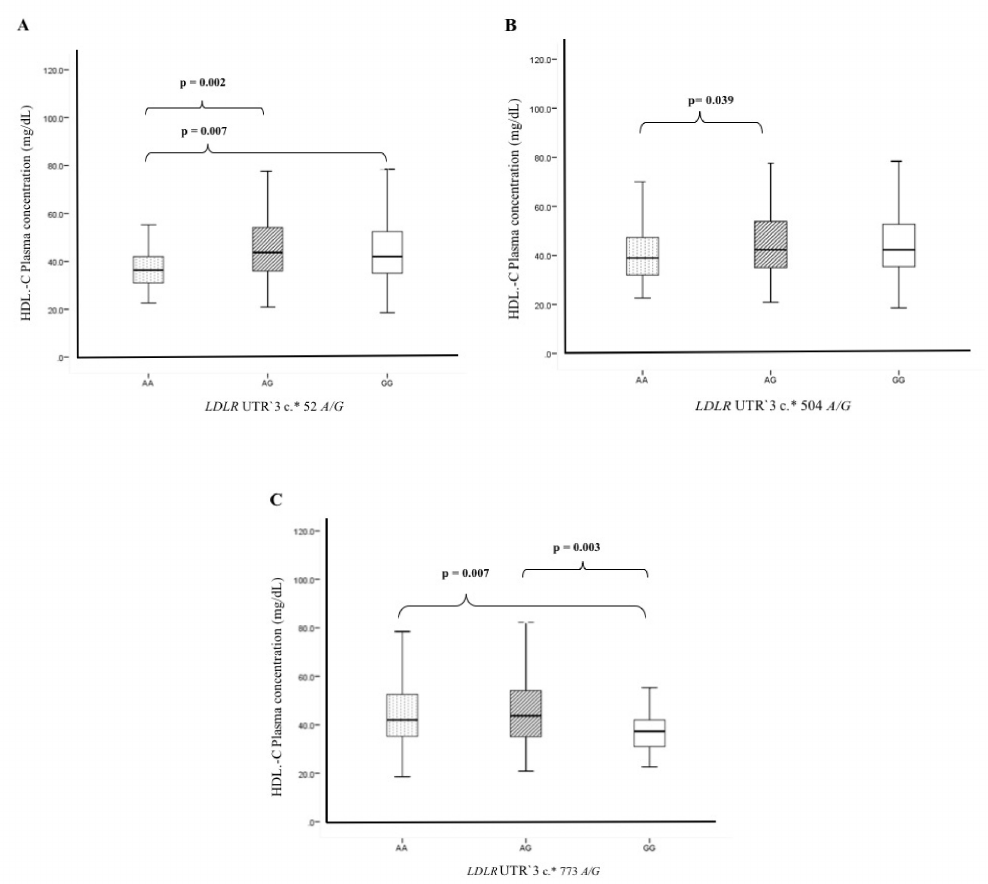
Figure 1. Genetic contribution of the LDLR UTR (cid:48) 3 c.*52 A / G, LDLR UTR (cid:48) 3 c.*504 A / G , and LDLR UTR‘3 c.* 773 A / G polymorphisms on HDL-C levels. ( A ) The AA genotype of the LDLR UTR (cid:48) 3 c.*52 A / G SNP showed low HDL-C levels in plasma when compared to AG / GG genotypes. ( B ) The AA genotype of the LDLR UTR (cid:48) 3 c.*504 A / G polymorphism showed lower HDL-C levels in plasma than the AG genotype. ( C ) The GG genotype of the LDLR UTR (cid:48) 3 c.* 773 A / G showed low HDL-C levels in plasma when compared to AA / AG genotypes.